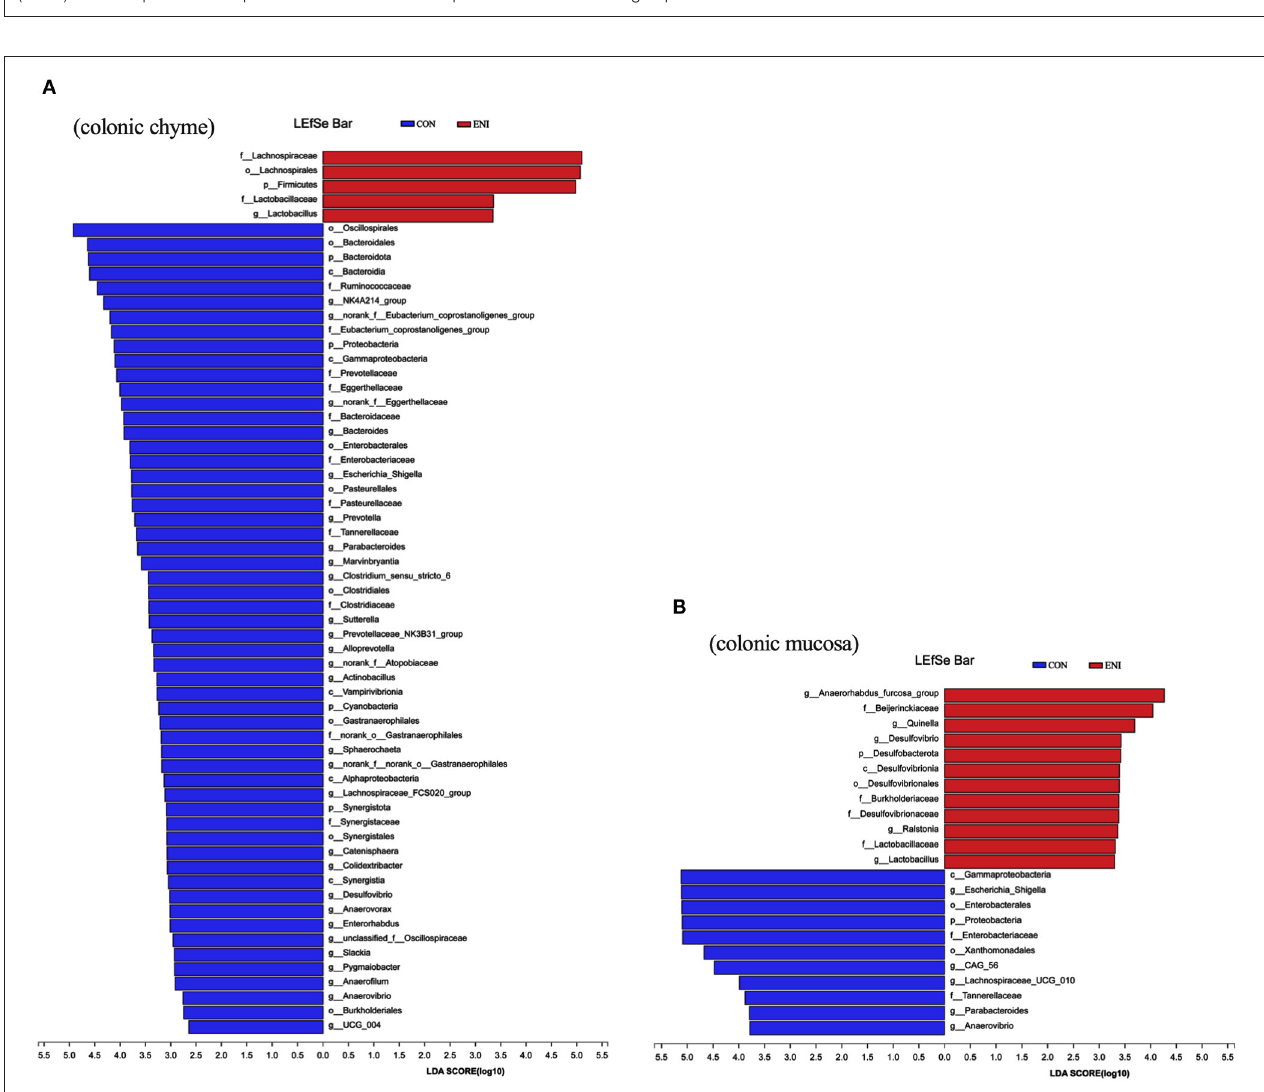
FIGURE 8 | The differentially abundant taxa among the two groups by LEfSe analysis. CON: control group, ENI: early-life nutrition interventions group. (A) LEfSe analysis of microbiota in colonic chyme. (B) LEfSe analysis of microbiota in colonic